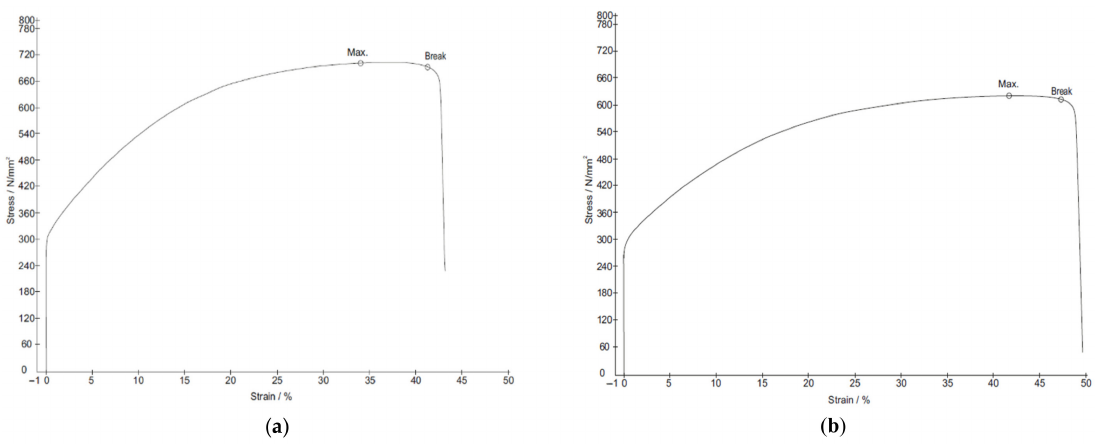
Figure 8. Stress − strain curve for: ( a ) OM1 and ( b )